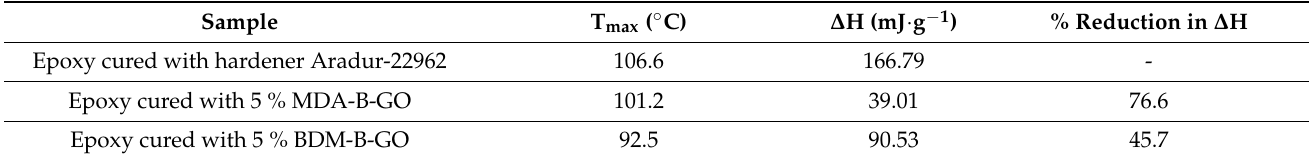
Table 3. Curing data of epoxy with aradur-22962 and oligoimides.